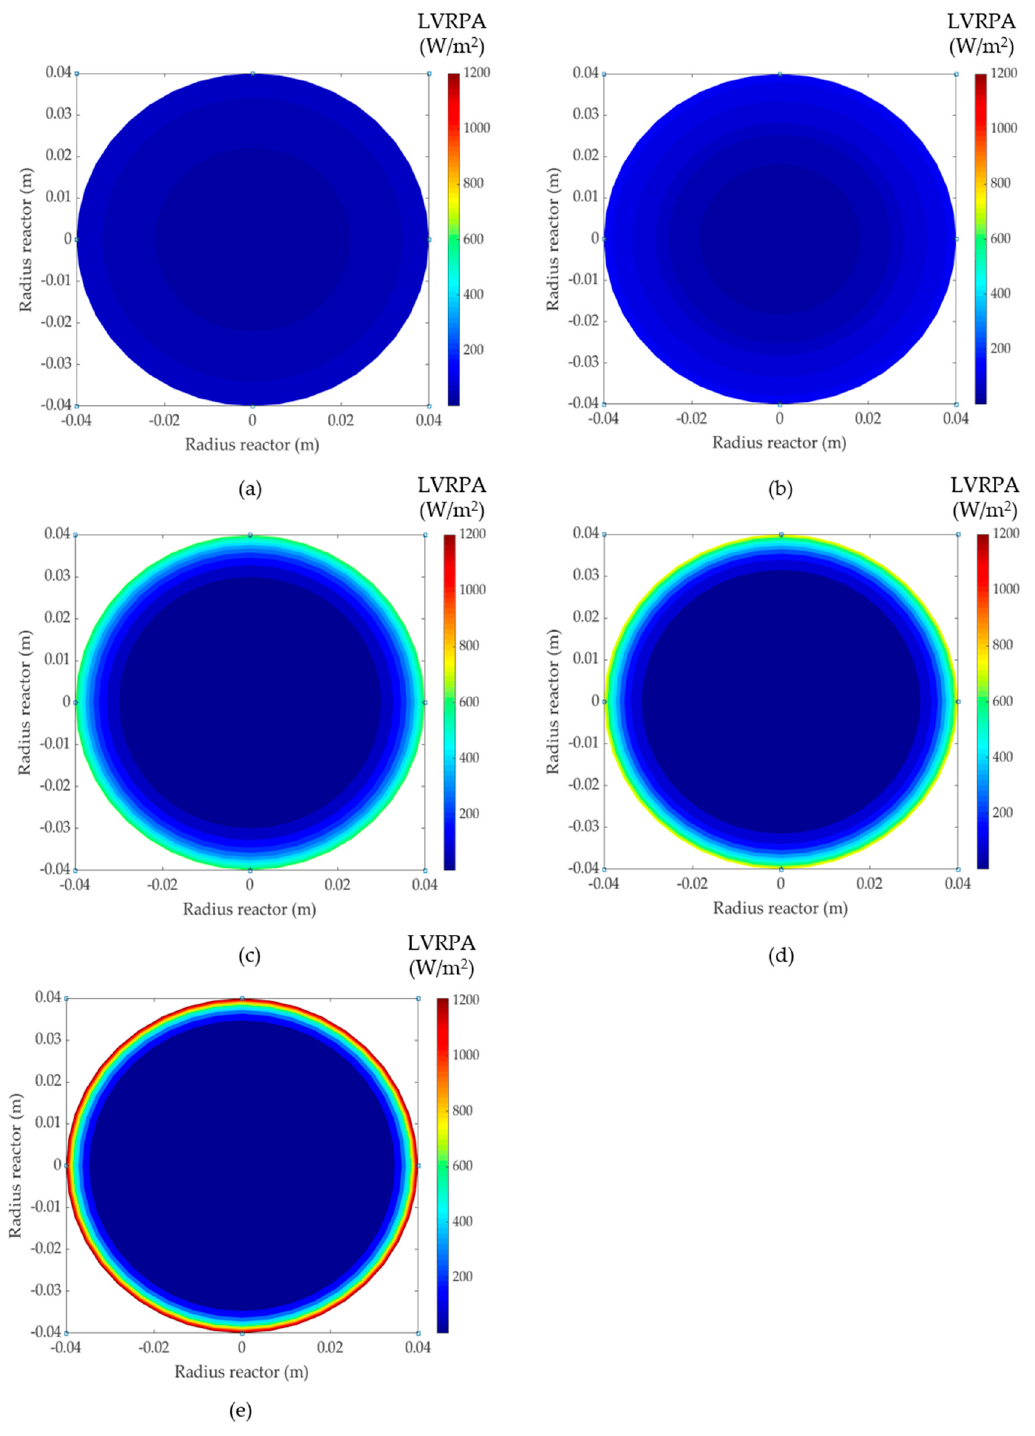
Figure 5. Simulated Local Volumetric Rate of Photon Absorption (LVRPA) values in the reactor for ( a ) 0.05 g/L TiO 2 , ( b ) 0.1 g/L TiO 2 , ( c ) 0.5 g/L TiO 2 , ( d ) 0.6 g/L TiO 2 and ( e ) 1.0 g/L TiO 2.